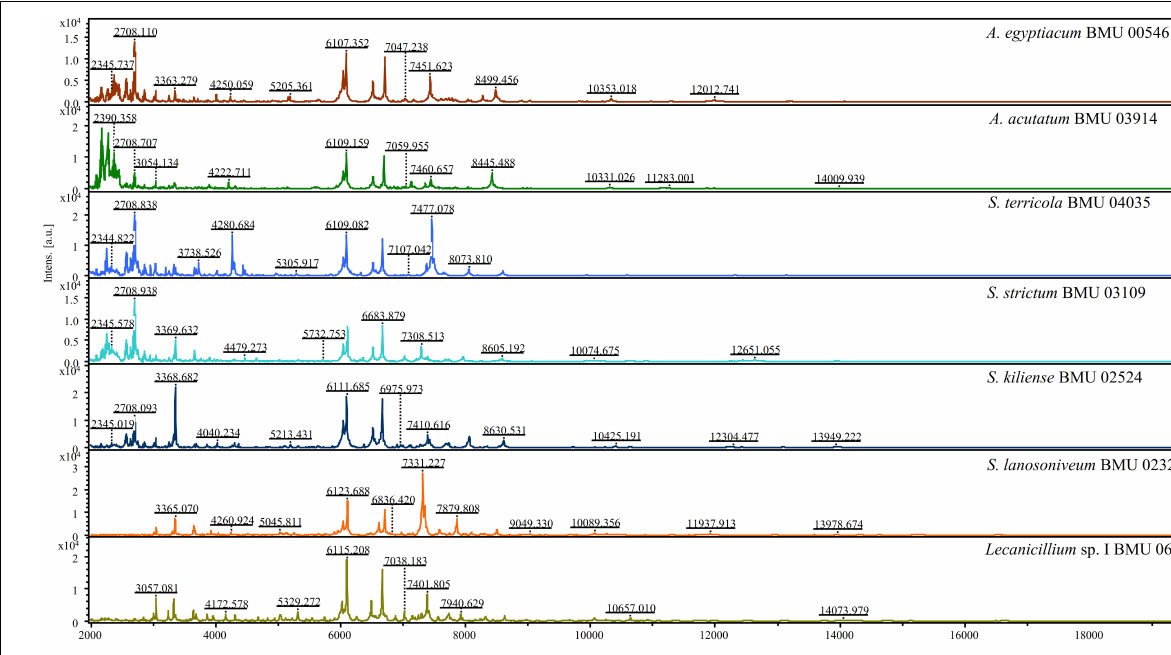
FIGURE 2 | Matrix-assisted laser desorption ionization-time-of-flight mass spectra (m/z 2,000 to 20,000) of Acremonium -like species.